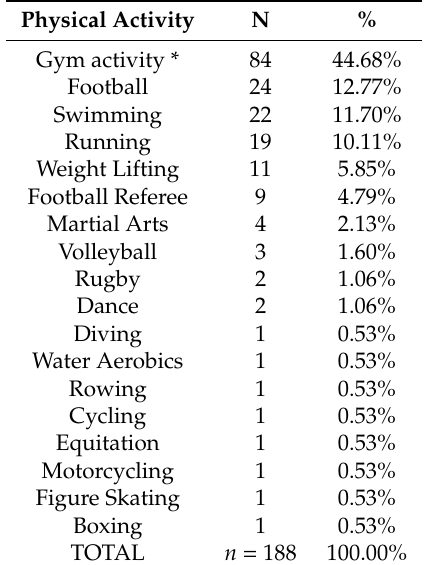
Table 1. Types and frequencies of physical activity (PA) performed by active respondents.